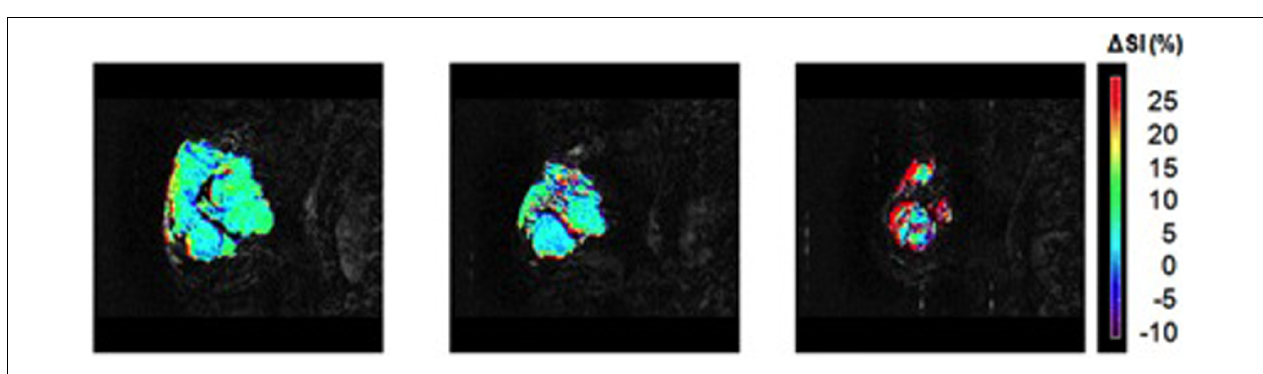
relative high rTBV, while placebo treated tumor present only one big region with significant rTBV. The color bar indicates the rTBV values in arbitrary units. Adapted from Dominietto etal. (2012), reproduced with permission.